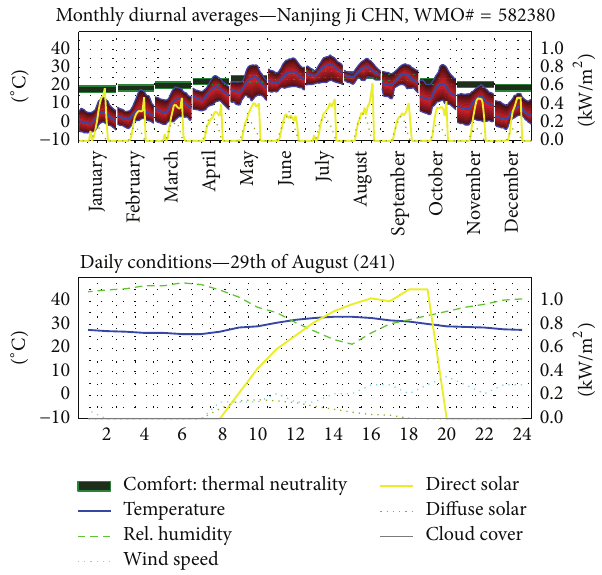
Figure 1: Annual meteorological data for